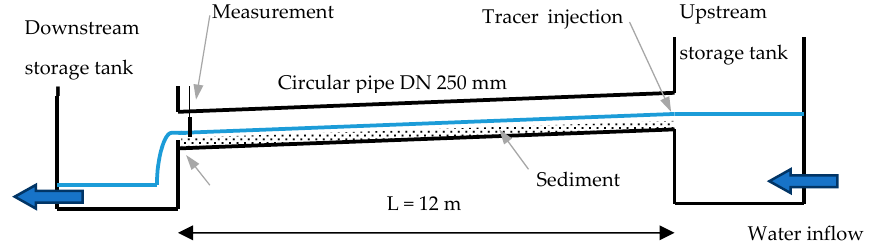
Figure 1. Scheme of the experimental device.